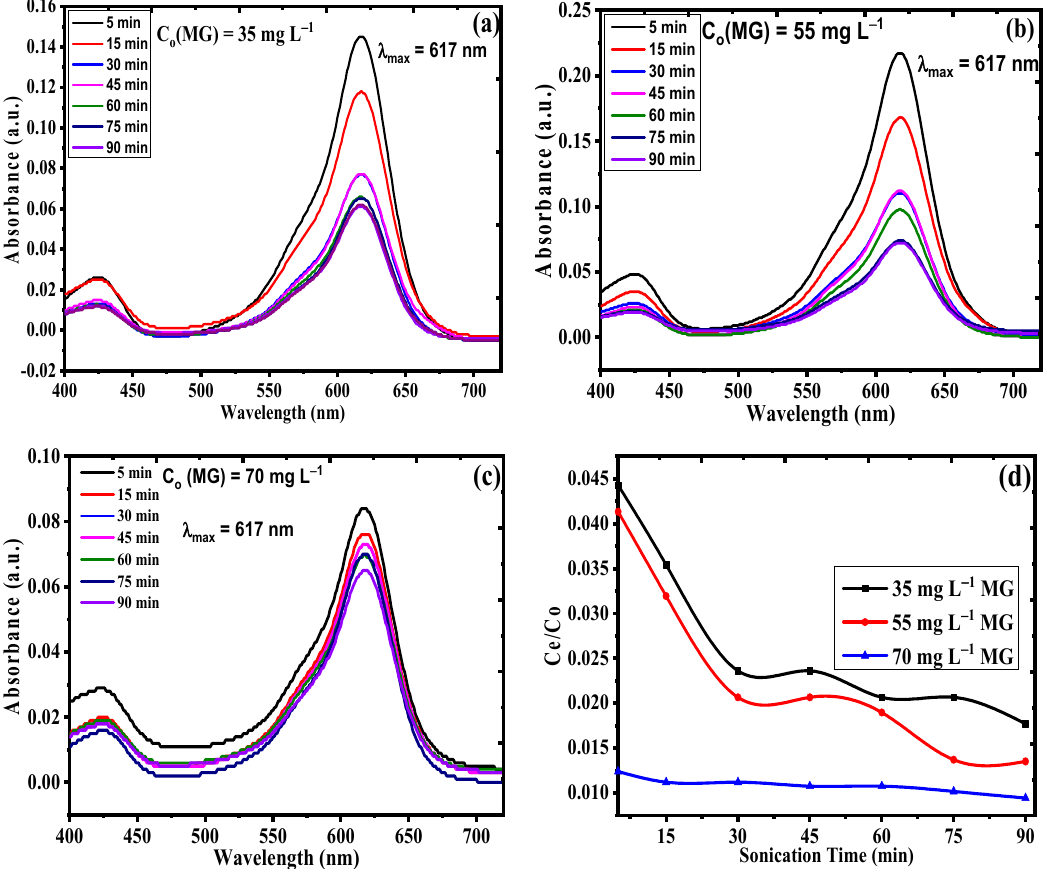
ff ect of variable sonication time for visible irradiation at Figure 8. UV-Vis action curve for the effect of variable sonication time for visible irradiation at ( a ) 35 Figure 8. UV-Vis action curve for the e ( a ) 35 mg · L − 1 , ( b ) 55 mg · L − 1 , and ( c ) 70 mg · L − 1 MG concentration, and ( d ) Ce / Co curve with respect to sonication time using 20 mg catalyst under 115 W ultrasonication and pH